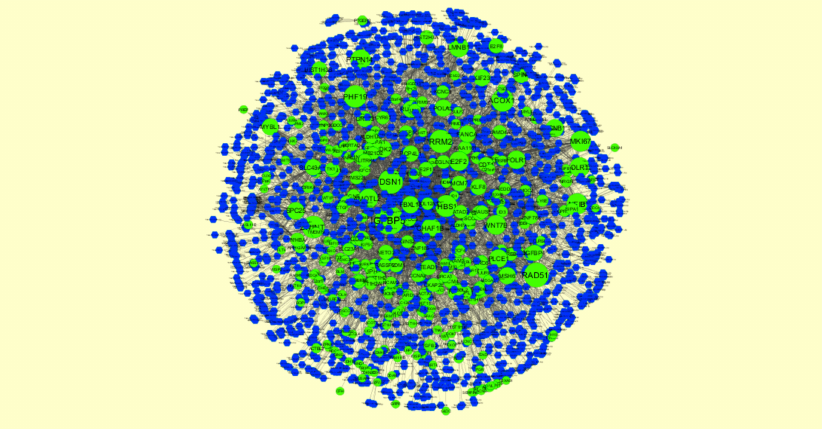
Figure 13. The network of up-regulated di ff erential expressed genes (DEGs) and their related miRNAs. The green circle nodes are the up-regulated DEGs, and blue diamond nodes are the miRNAs.